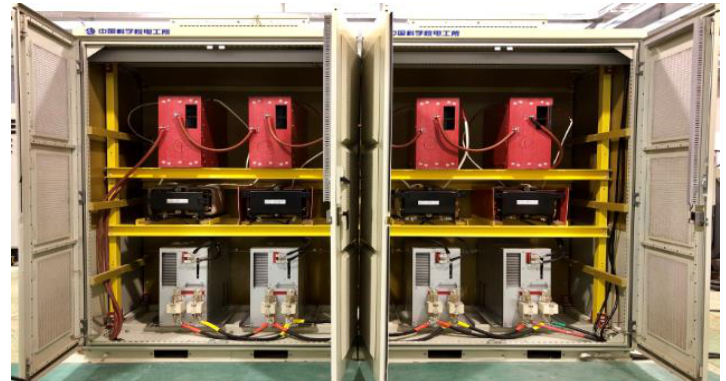
Figure 19. Experimental platform based on four modules.